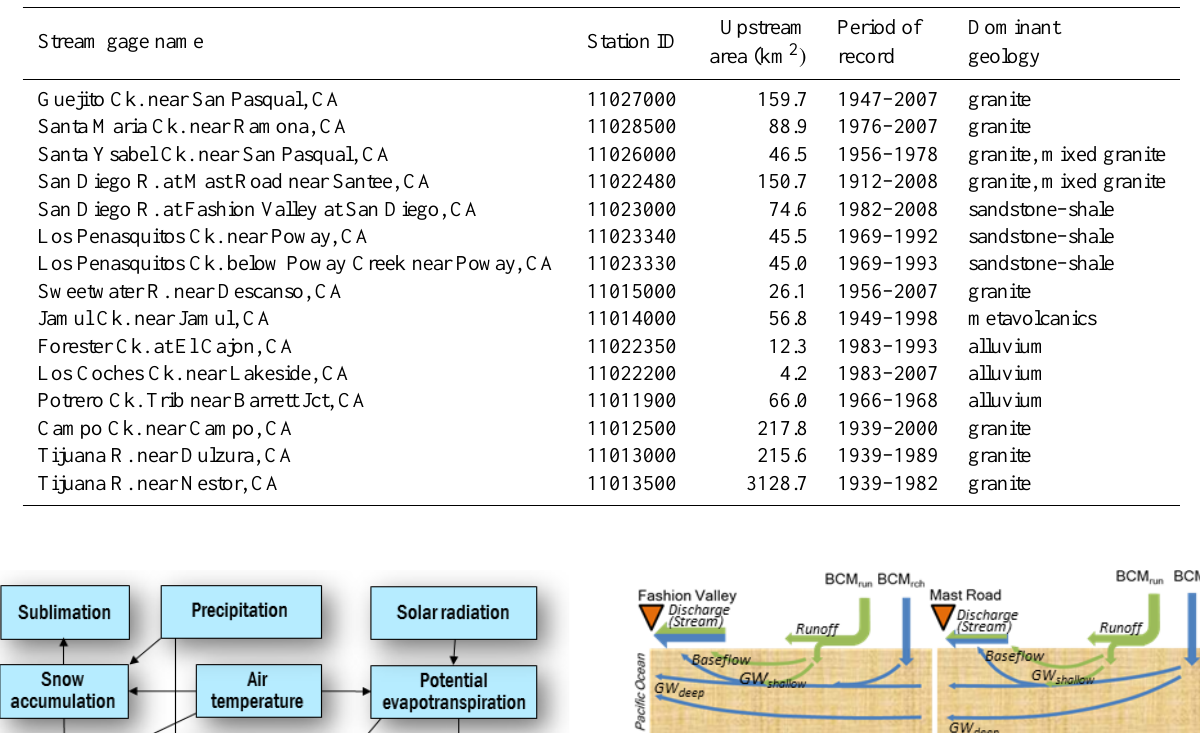
Fig. 5. Schematic illustrating the application of runoff and recharge from the Basin Characterization Model to the surface-water and groundwater system in the San Diego River